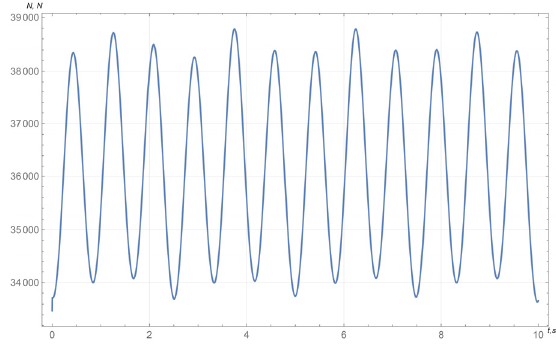
Figure 10. The spatial trajectory of the beam center of mass (point C)